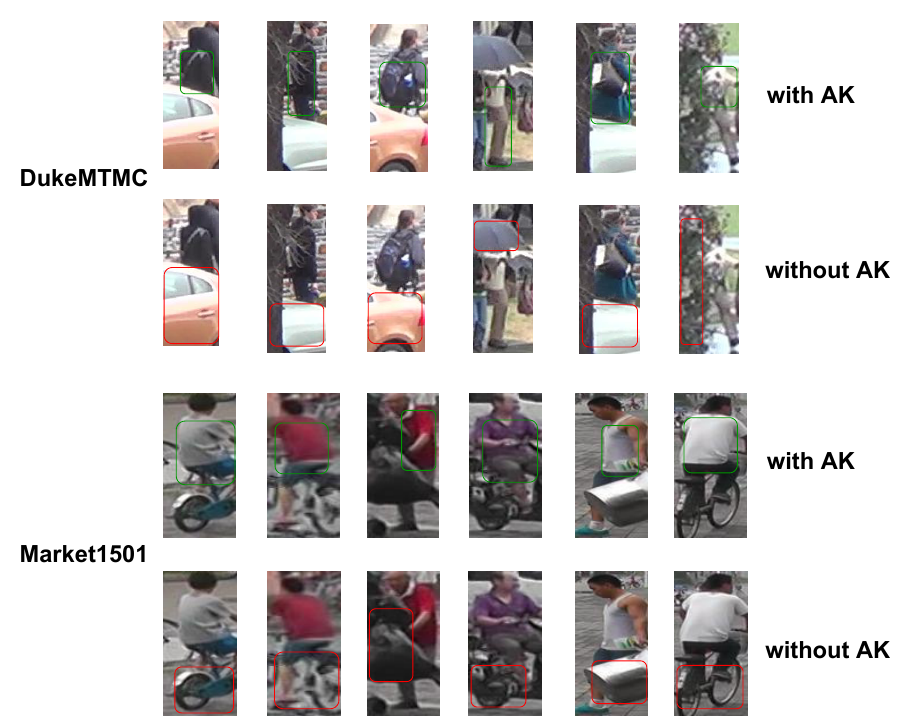
Figure 4. Compare the attention changing influenced by using attribute knowledge on two datasets. Here, AK represents attribute knowledge.